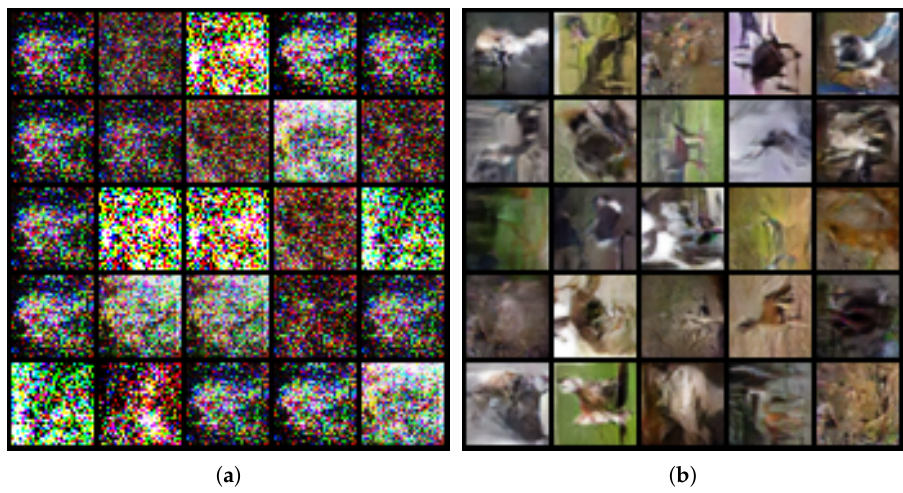
Figure 1. Using a too-simple generator model ( a ), the open-set classifier model does not learn to reject real unknown samples by rejecting these fake ones. However, a complex model generates too-realistic images ( b ), possibly even fooling humans, and the classifier cannot learn to reject these while correctly classifying positive samples. ( a ) Fake images generated by a simple model. ( b ) Fake images generated by a complex